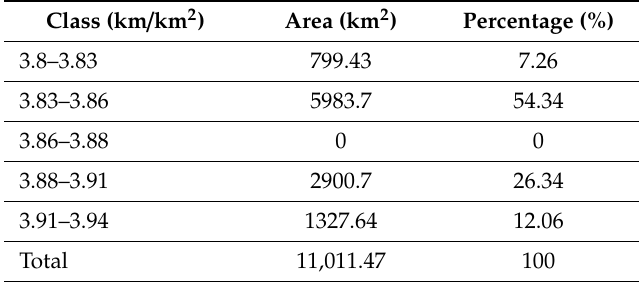
Table 17. Drainage density analysis for Al-Shamal train pathway in Al-Qurayyat city in 2020.